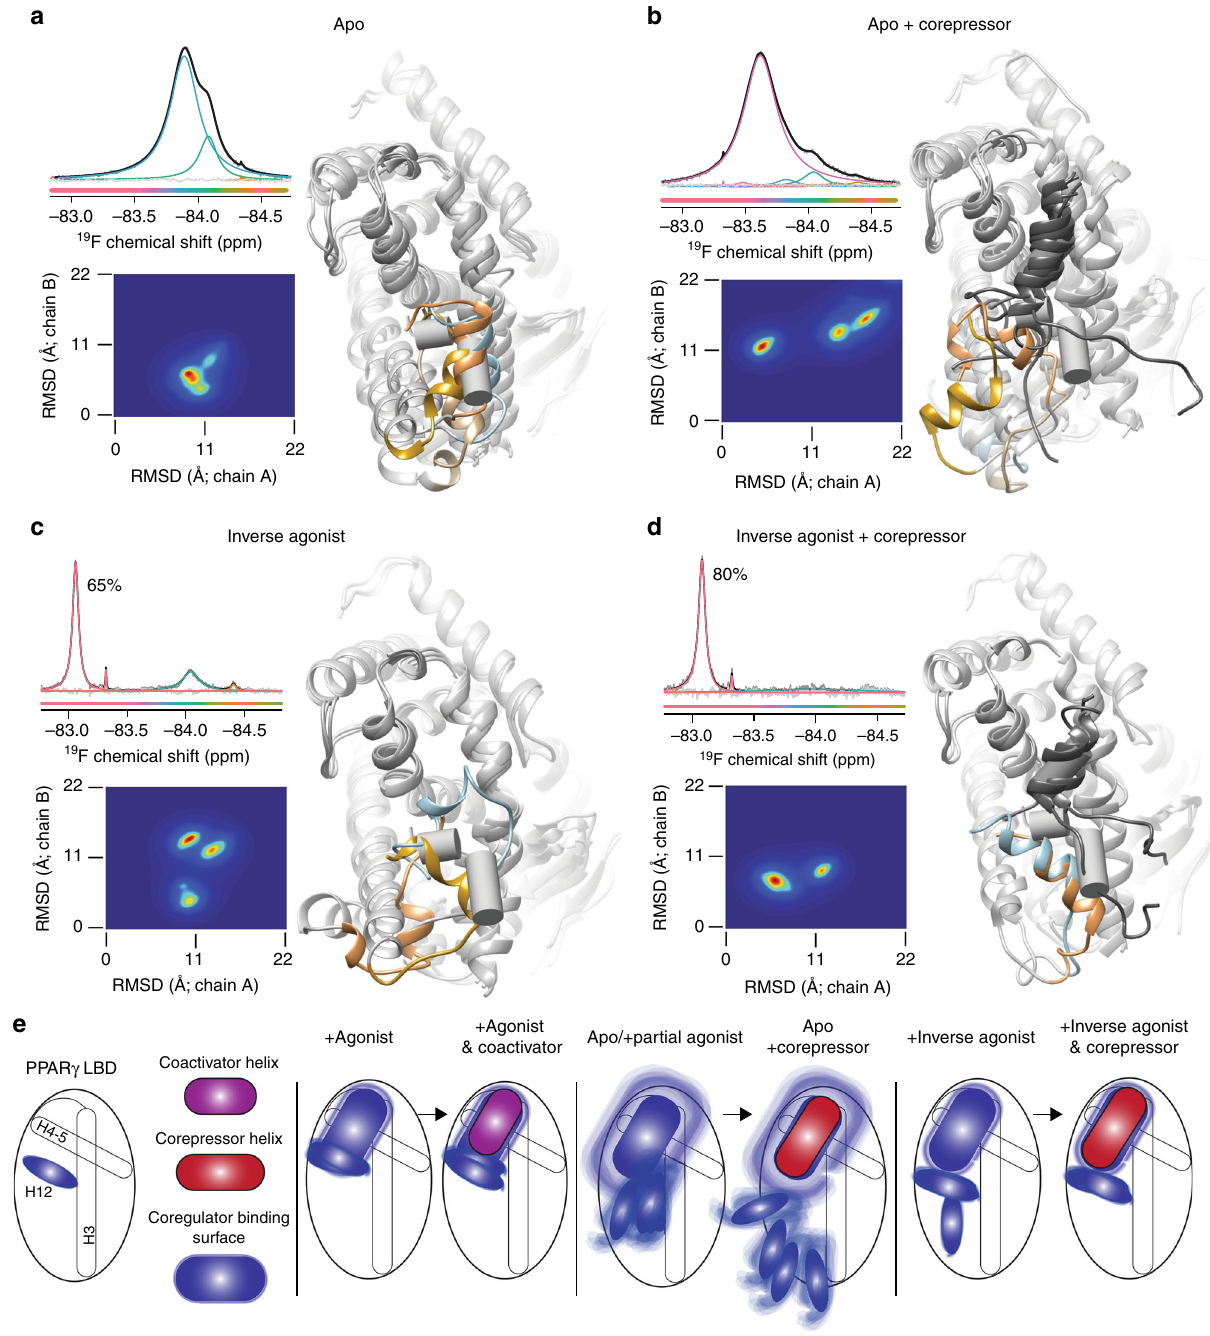
Fig. 9 Microsecond time-scale molecular simulations point to a possible NCoR bound structure. a – d Root mean square deviation (RMSD) of helix 12 relative to an inactive (1PRG chain B) structure and an active conformation (1PRG chain A) for helix 12 in four different simulated complexes. Helix 12 from these inactive and active structures is shown in all panels (gray pipe). SMRT bound to PPAR α (PDB code: 1KKQ) was aligned to 1PRG chain A and the SMRT helix is shown in b and d (gray pipe). Fourteen independent simulations of a apo PPAR γ LBD, b apo + NCoR corepressor, c inverse-agonist (T0070907)-bound PPAR γ LBD, and d PPAR γ LBD co-bound to T0070907 and NCoR corepressor were carried out for 10 to 30 μ s and the last 5 μ s were analyzed (4 each for apo simulations and 3 each for T0070907 simulations). Colors on the RMSD plots indicate relative number of frames; red indicates the most prevalent and blue the least. Representative structures from the centroid of the major clusters are shown with helix 12 highlighted in color (4 apo, 4 apo + NCOR, 3 T0070907 and 2 T0070907 + NCoR). Helix 12 disassociates from the LBD in one apo + NCoR simulation. The cluster for this simulation (centered at 21.3 Å ( x ) and 23.8 Å ( y )) is not shown; however, a representative structure is shown in light blue. Corresponding 19 F NMR data from Fig. 7 are shown in each panel. e A model for helix 12 conformational diversity based on simulation and experiment. Apo PPAR γ or partial-agonist-bound PPAR γ helix 12 is found in many similar conformations of varying helical structure producing broad NMR peaks and rapid hydrogen deuterium exchange, while full agonist is found in a tighter cluster of conformations. Co-binding of the inverse agonist T0070907 and the corepressor NCoR produces one main conformation similar to an active conformation, but with helix 12 shifted. Fuzziness implies intermediate exchange ( μ s to ms) between the